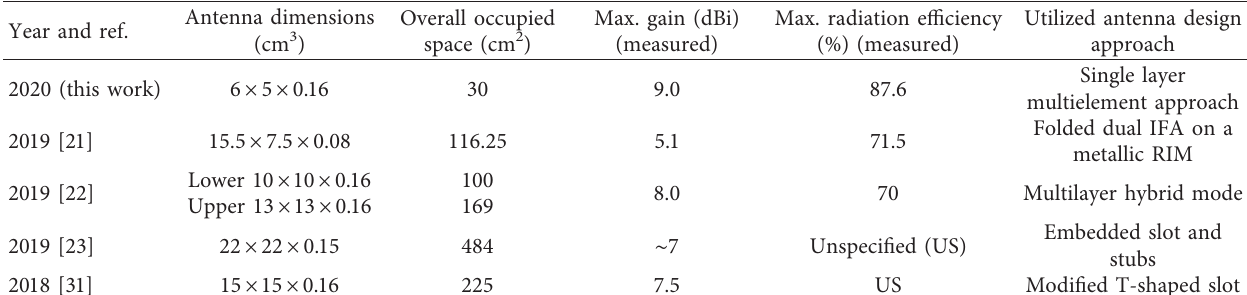
Figure 10: Simulated and tested normalized patterns. (a) E-plane (XoZ) Co-X polarization at 10.8GHz. (b) H-plane (YoZ) Co-X po- larization at 10.8GHz. Table 2: Antenna key features of compared